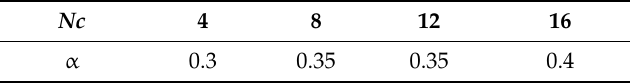
Table 5. Bending proportion of radial strain of the